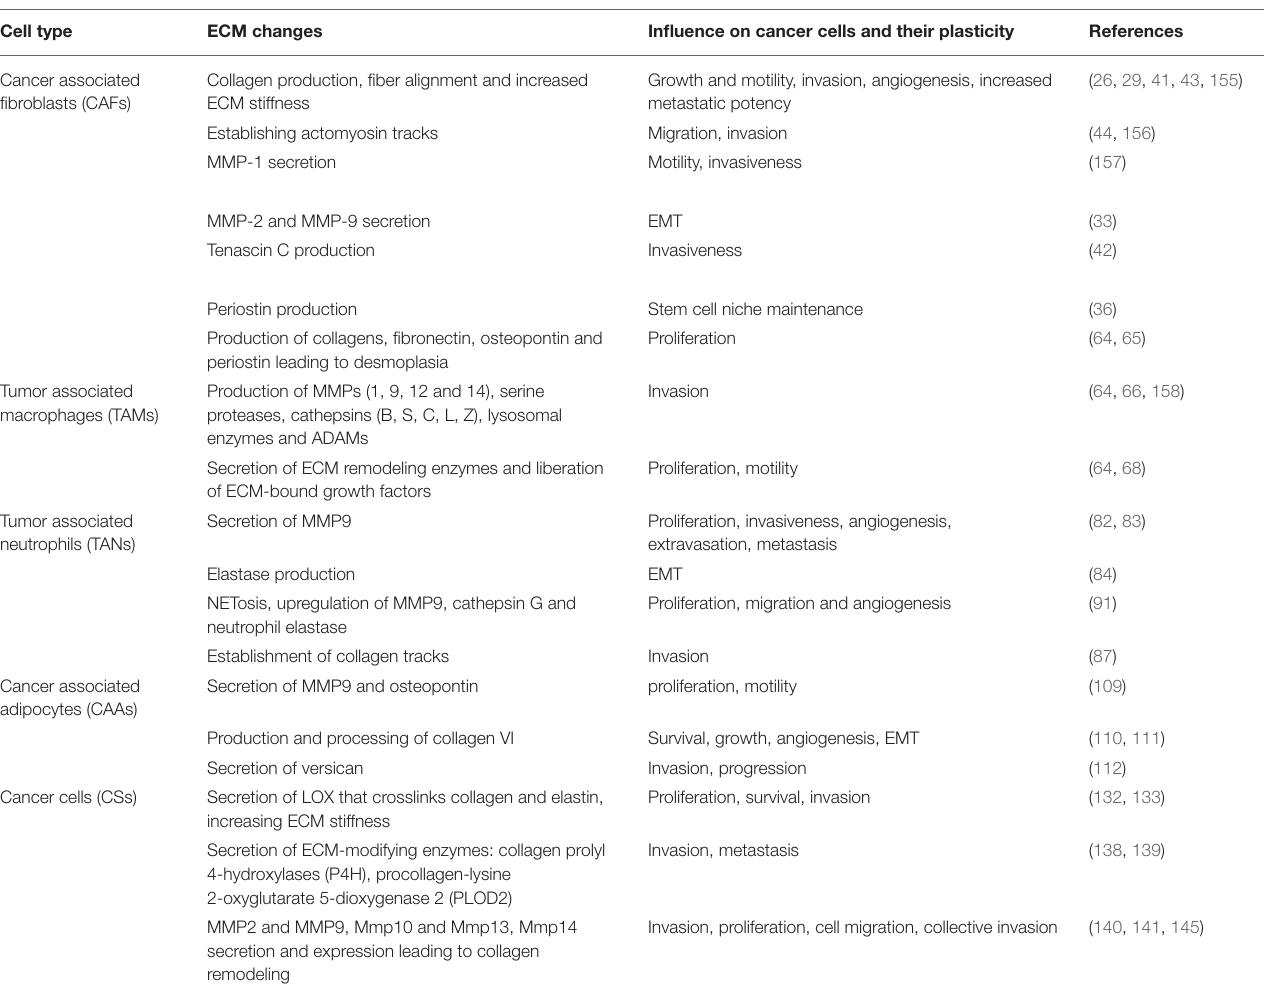
TABLE 1 | Cellular regulators of the ECM and cancer cell